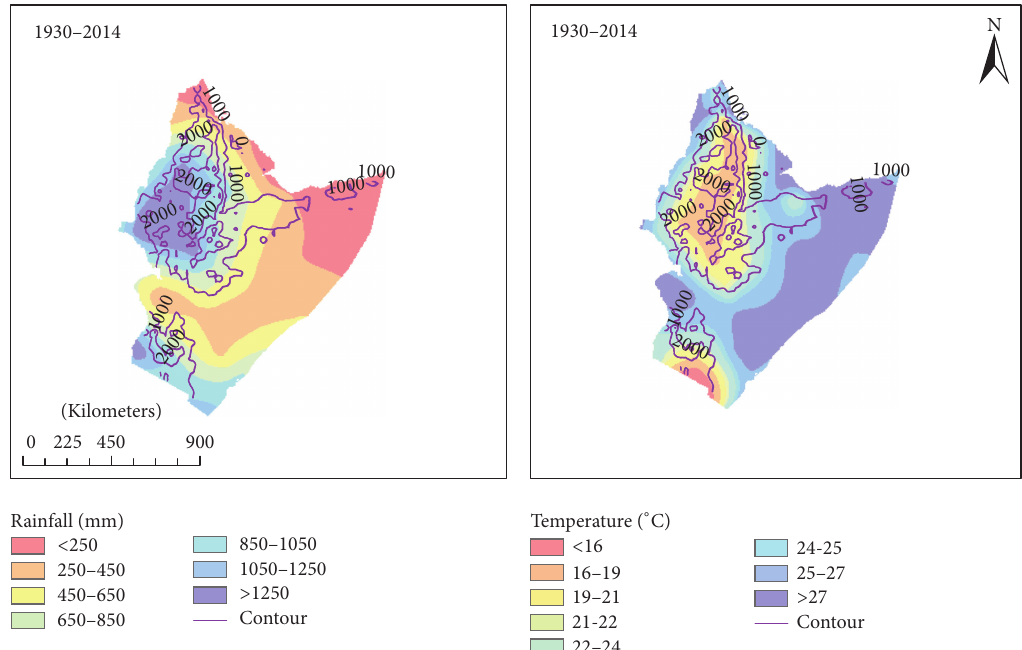
Figure 2: Long-term spatial interpolation of precipitation and temperature in the